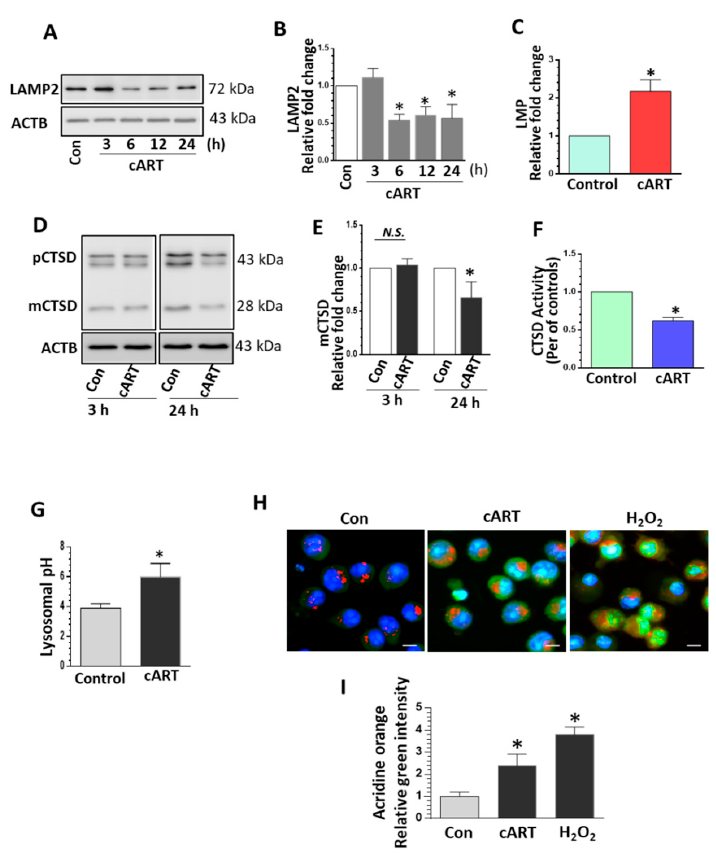
Figure 1. Exposure of rat primary microglial cells (rPMs) to combined antiretroviral therapy (cART) cocktail resulted in impaired lysosomal function. rPMs were seeded into six-well plates and treated with cART (5 µ M each of tenofovir disoproxil fumarate (TDF), emtricitabine (FTC), and dolutegravir (DTG)) for the indicated time periods. ( A , B ) Exposure of microglia to cART resulted in a significant decrease in expression of lysosomal-associated membrane protein 2 (LAMP2) at 6 to 24 h post-treatment. ( C ) Representative bar graph showing cART-mediated significantly increased lysosomal membrane permeabilization (LMP) (24 h). ( D , E ) Microglia exposed to cART demonstrated a significant decrease in levels of mature cathepsin D (mCTSD) at 24 h post-treatment. ( F ) Representative bar graph showing exposure of cART significantly reduced the CTSD activity in rPMs (24 h). ( G ) Representative bar graph showing cART-mediated increased lysosomal pH in rPMs. ( H , I ) Acridine orange staining showing increased green color and reduced red color in cART-treated rPMs. H 2 O 2 was used as a positive control for lysosome damage. Data is from three independent experiments. Actin beta (ACTB) served as a protein loading control for western blots. Data are expressed as means ± SEM and were analyzed using student t-test or one-way ANOVA. *, p < 0.05 vs. control; N.S.,